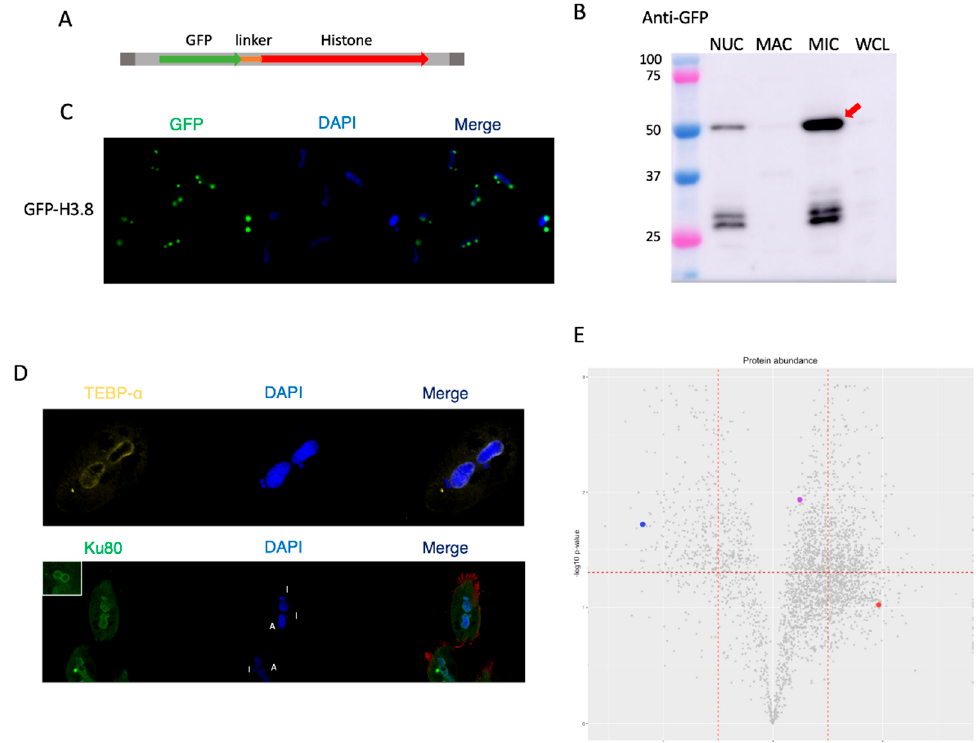
Figure 5. Validation of nuclear localization results from MS. ( A ) Schematic of the artificial chromosome used to transform Oxytricha with an N-terminal GFP-tagged H3 histone. A ciliate codon-corrected GFP was inserted at the N-terminus of the gene along with a flexible linker. The double-stranded portion of the nanochromosome’s telomeres were included at both ends. ( B ) Western blot analysis of samples from cells transformed with the previously described construct including unseparated nuclei (NUC), enriched MAC, enriched MIC, and whole cell lysate (WCL) using an anti-GFP antibody. The expected band of approximately 48 kDa is marked with an arrow. The smaller bands between 25 and 37 kDa are close to the size of free GFP (27 kDa). ( C ) Fluorescence imaging of the GFP-tagged strain depicting the specific MIC localization of the transgene with DAPI to visualize the nuclei. ( D ) Immunofluorescence imaging of vegetative JRB310 cells using custom antibodies raised against Oxytricha TEBP- α or Ku80, with DAPI to visualize nuclei demonstrating the MAC-specific localization of TEBP- α and the nonspecific nuclear localization of Ku80. ( E ) Volcano plot with the 3 validated proteins depicted as colored spots. TEBP- α is labeled in blue, Ku80 in purple, and H3.8 in red.